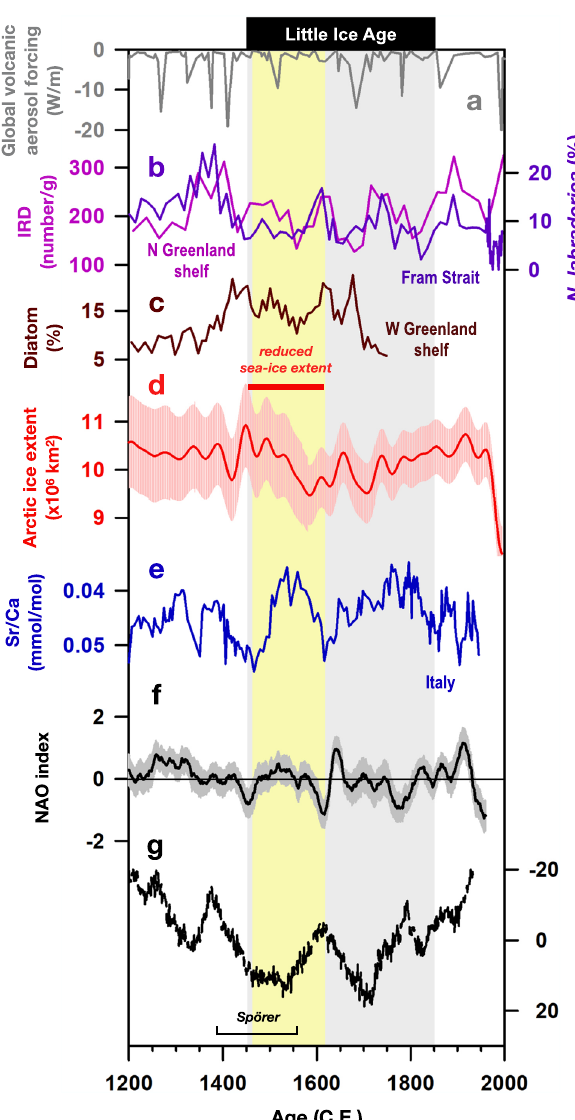
Fig. 3 | Comparison of volcanic forcing, solar activity, sea-ice variability, and Bàsura record. a Global volcanic aerosol forcing 16 . b Violet: concentration of benthic foraminifera from the North Greenland shelf (PS2641-4; Supplementary Fig. 2) as an indicator of sea-ice cover 50 . Pink: ice-rafted debris (IRD) (MSM5/5; Supplementary Fig. 2) from the Fram Strait 49 . High values of these two records denote large sea-ice cover. c Five-point averaged diatom concentration ( Tha- lassiosiranordenskioeldii )fromthewestGreenlandshelf(GA306-4;Supplementary Fig. 2) 51 . High value denotes large sea-ice cover. d Red: 40-year smoothed recon- structedlatesummerArcticsea-iceextent 56 . e BàsuraSr/Carecord. f Reconstructed NAO index 11 . g Total solar irradiance 12 . The intervals of the Spörer Minimum (1388 – 1558C.E.) 12 and decreased sea-ice event (1450 – 1620 C.E.) 56 are marked. The grey vertical bar denotes the Little Ice Age. The yellow vertical bar highlights the period 1470 – 1610